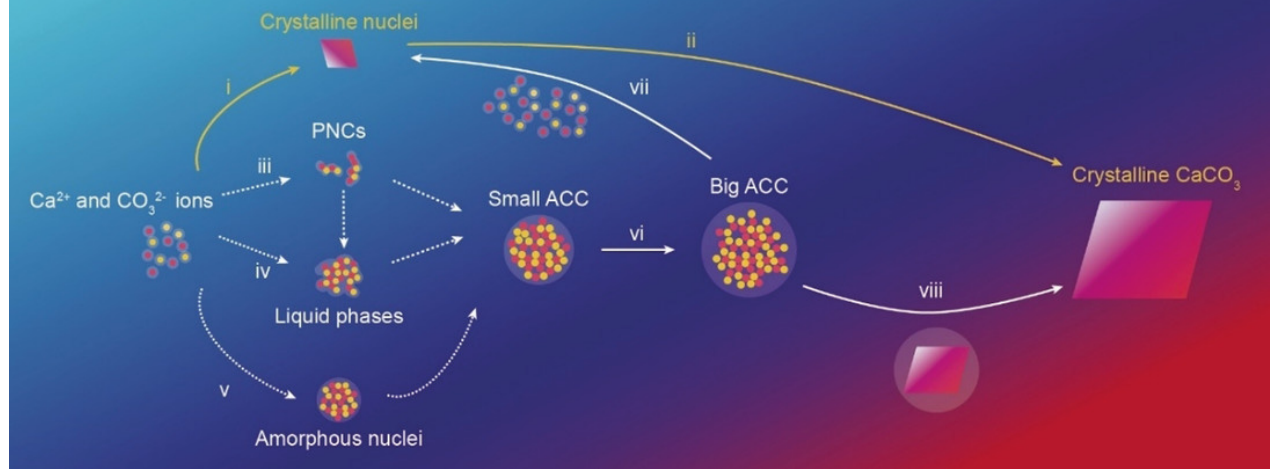
Figure 3. Schematic illustration of proposed mechanisms of the CaCO 3 formation. Reproduced